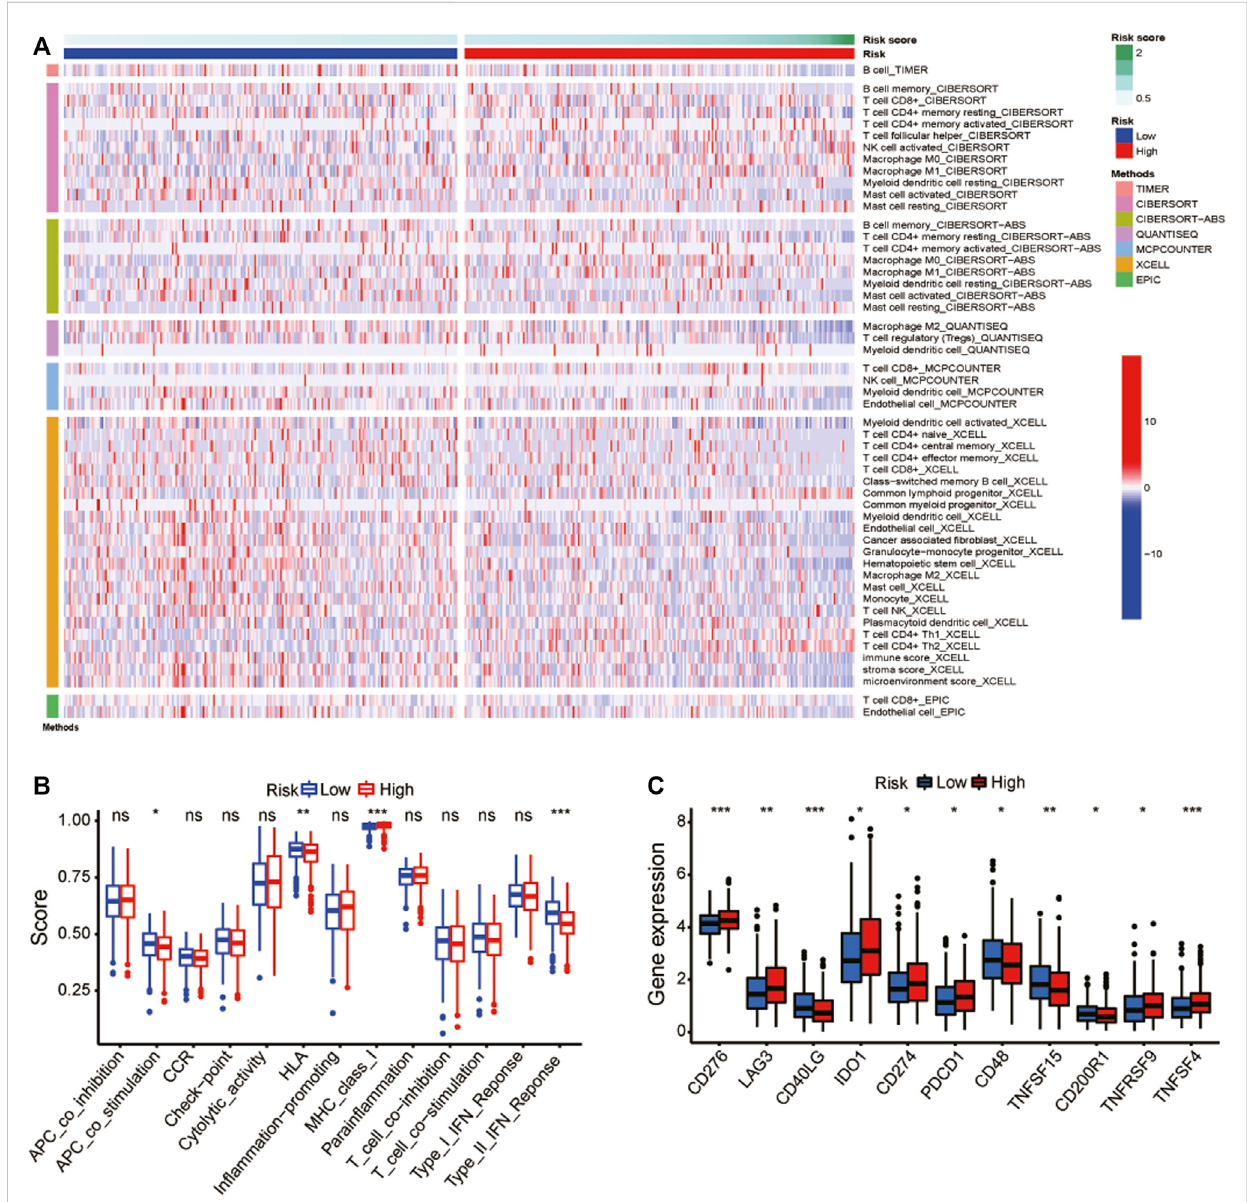
FIGURE 8 Gene expression and immune function. (A) A heat map for immunological responses between high- and low-risk groups. (B) Immune cell subpopulationsandassociatedfunctions. (C) Expressionofimmunecheckpointsinhigh-riskandlow-riskgroups.* p < 0.05,** p < 0.01,and*** p < 0.001; ns: no signi fi